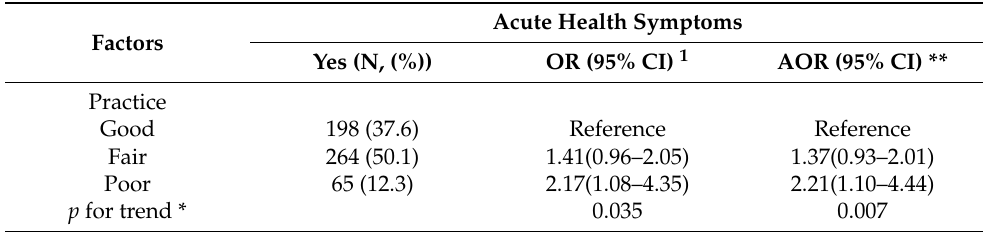
Table 6. Predictive factors of acute health symptoms among farmers in Nakhon Sawan (N =